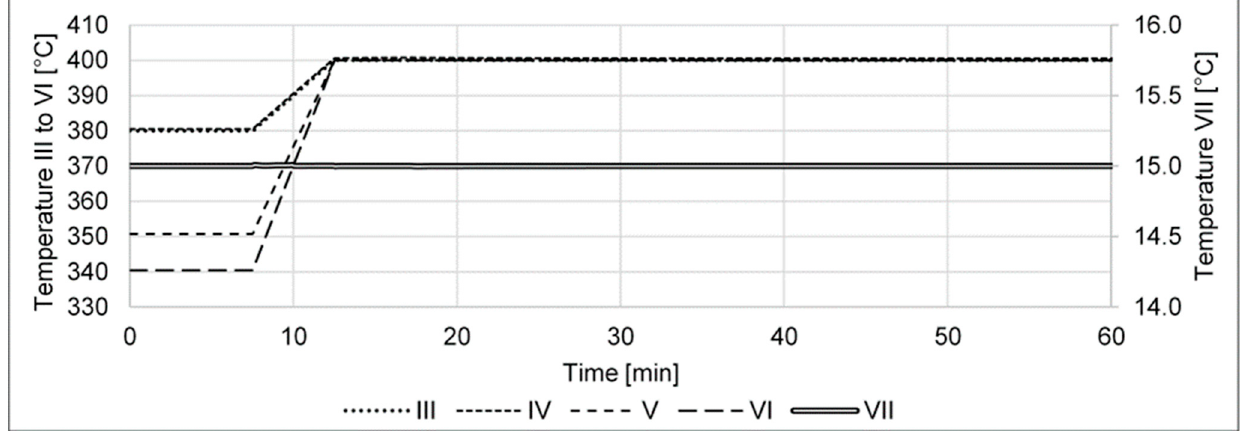
Figure 23 . Temperatures of selected streams of scenario (i). Figure 23. Temperatures of selected streams of scenario (i).